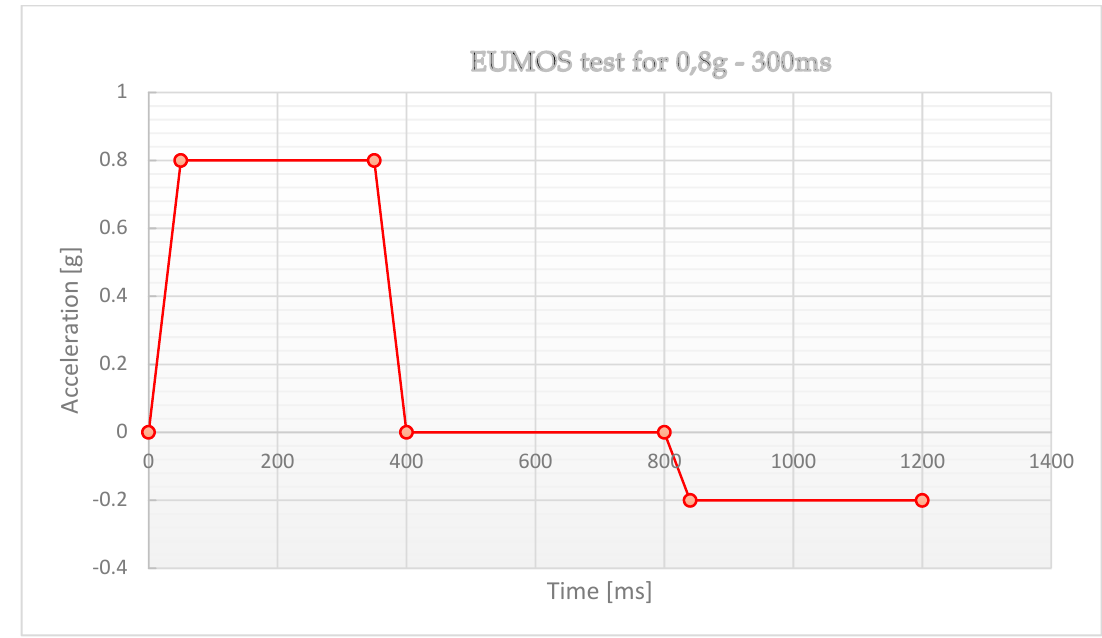
Figure 4. Simulation diagram for acceleration and deceleration of the cargo on the vehicle, according to EUMOS 40509.